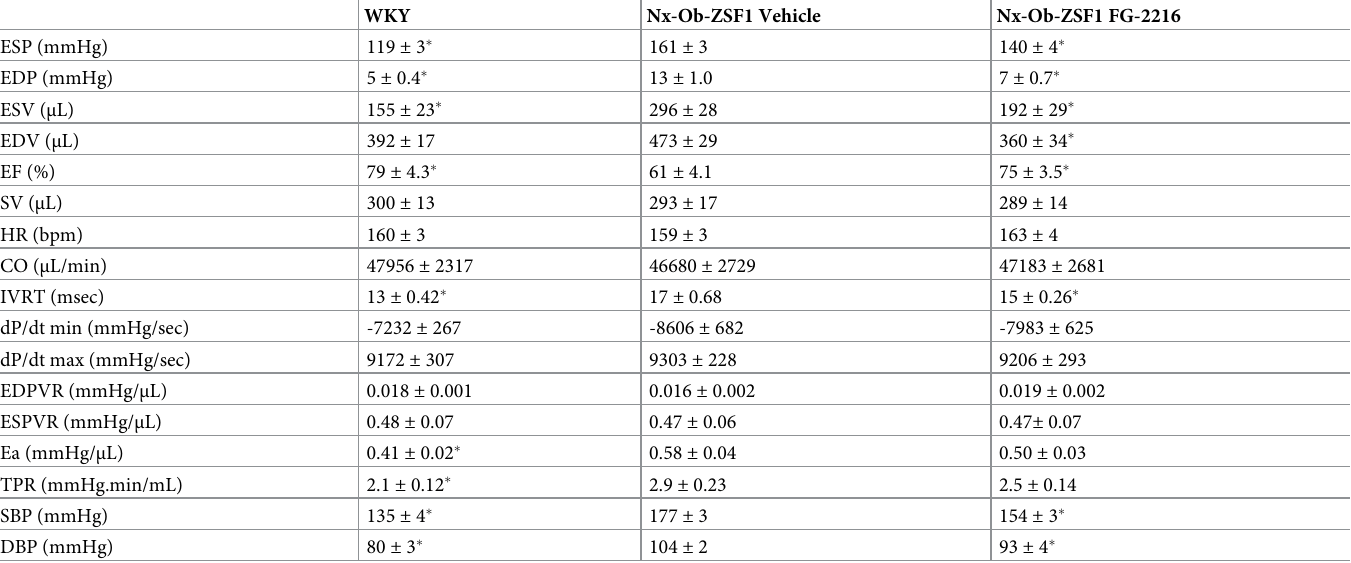
Table 2. FG-2216 improved cardiac function in Nx-Ob-ZSF1